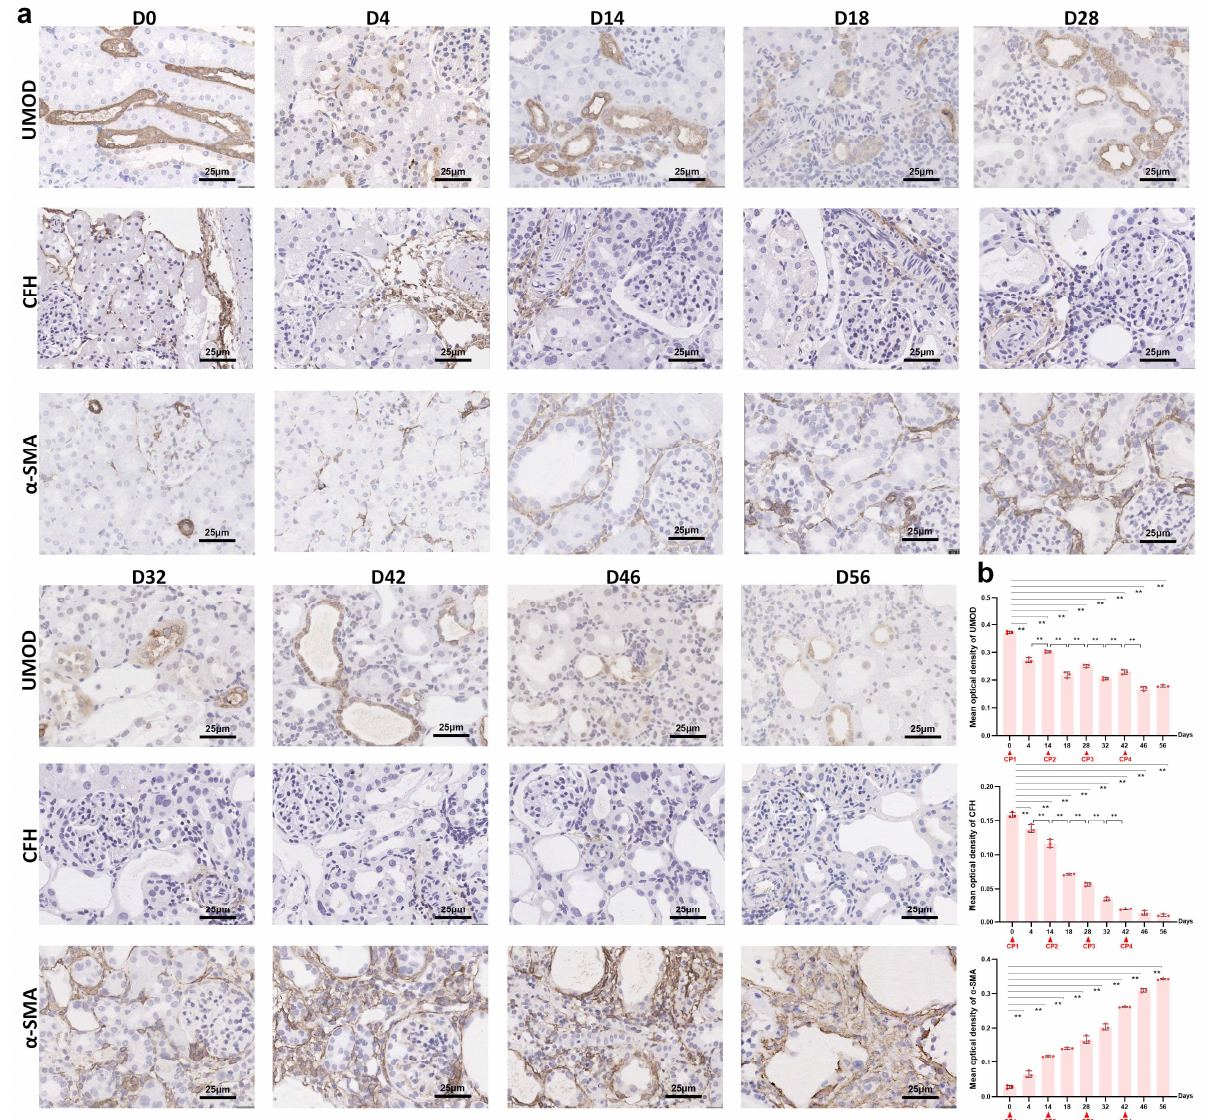
Figure 5. Immunohistochemical staining of uromodulin, CFH and α -SMA in kidneys on a series of days. ( a ) Representative micrographs (40 × , bar = 25 µ m) and ( b ) quantification of positive staining on kidney sections on different days as indicated (n = 3). ** p < 0.01 between the two groups. CP,